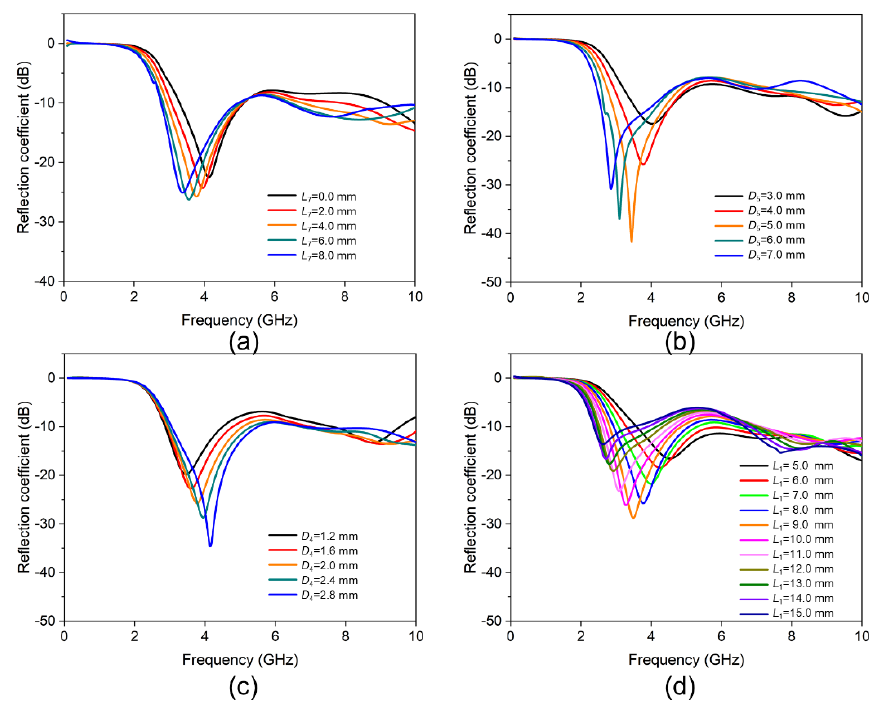
Figure 3. The impact of geometric parameters on the reflection coefficients of the antenna: ( a ) L 7 , ( b ) D 5 , ( c ) D 4 , and ( d ) L 1 . Table 1. Dimensions of the Optimized Antenna (Unit: mm).